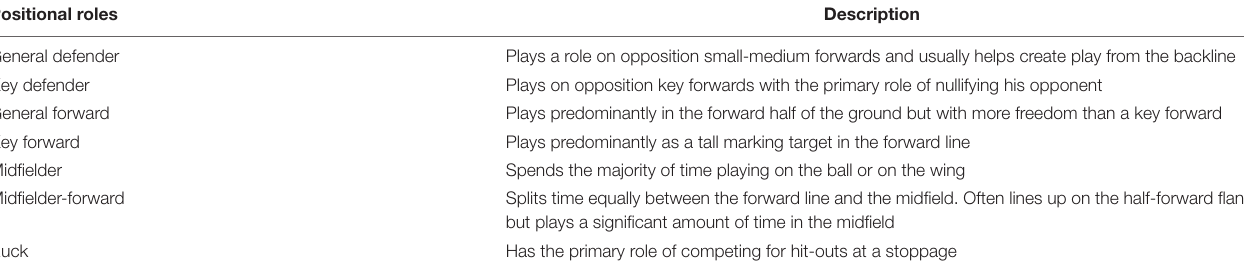
TABLE A1 | Descriptions of the seven positional roles used in this study.